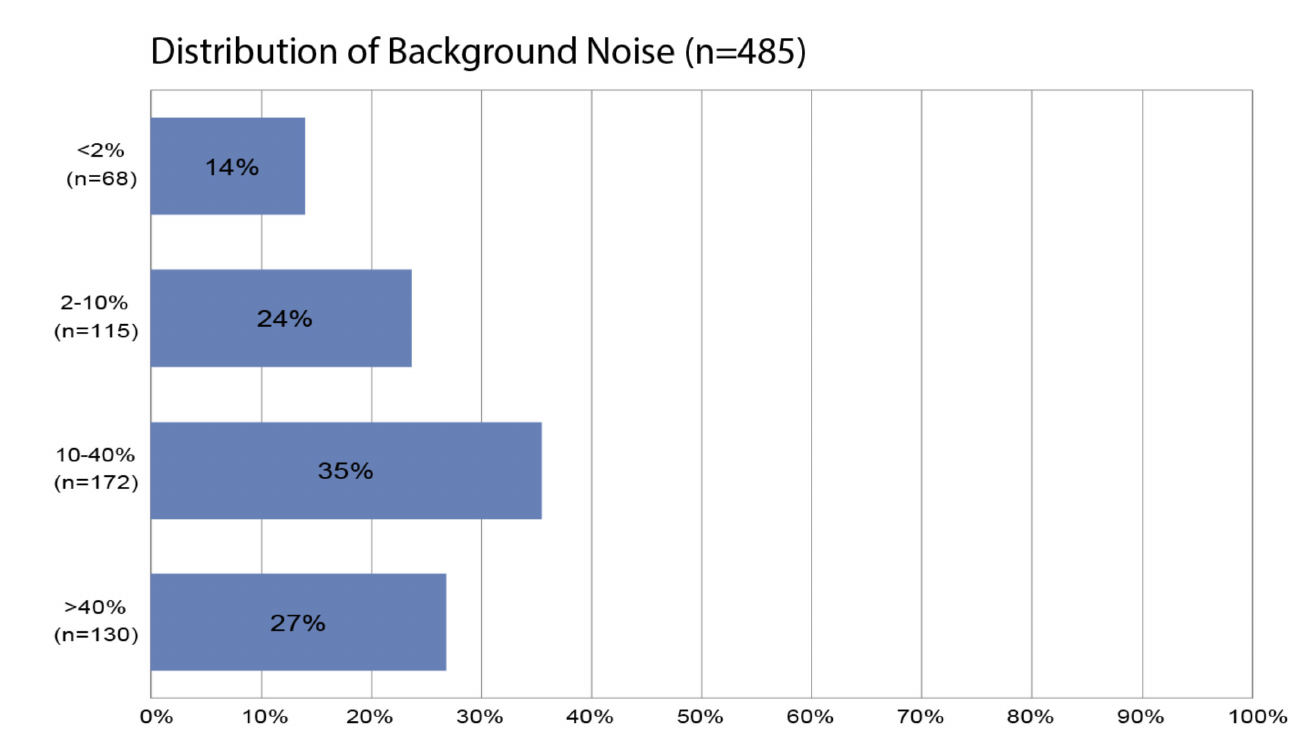
Figure 7. Distribution in distributed noise level for 485 questionnaire